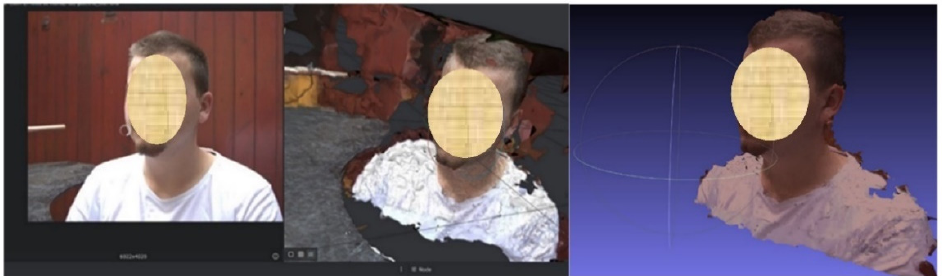
Figure 11. The final 3D model ready to be able to test the spectacle frame.